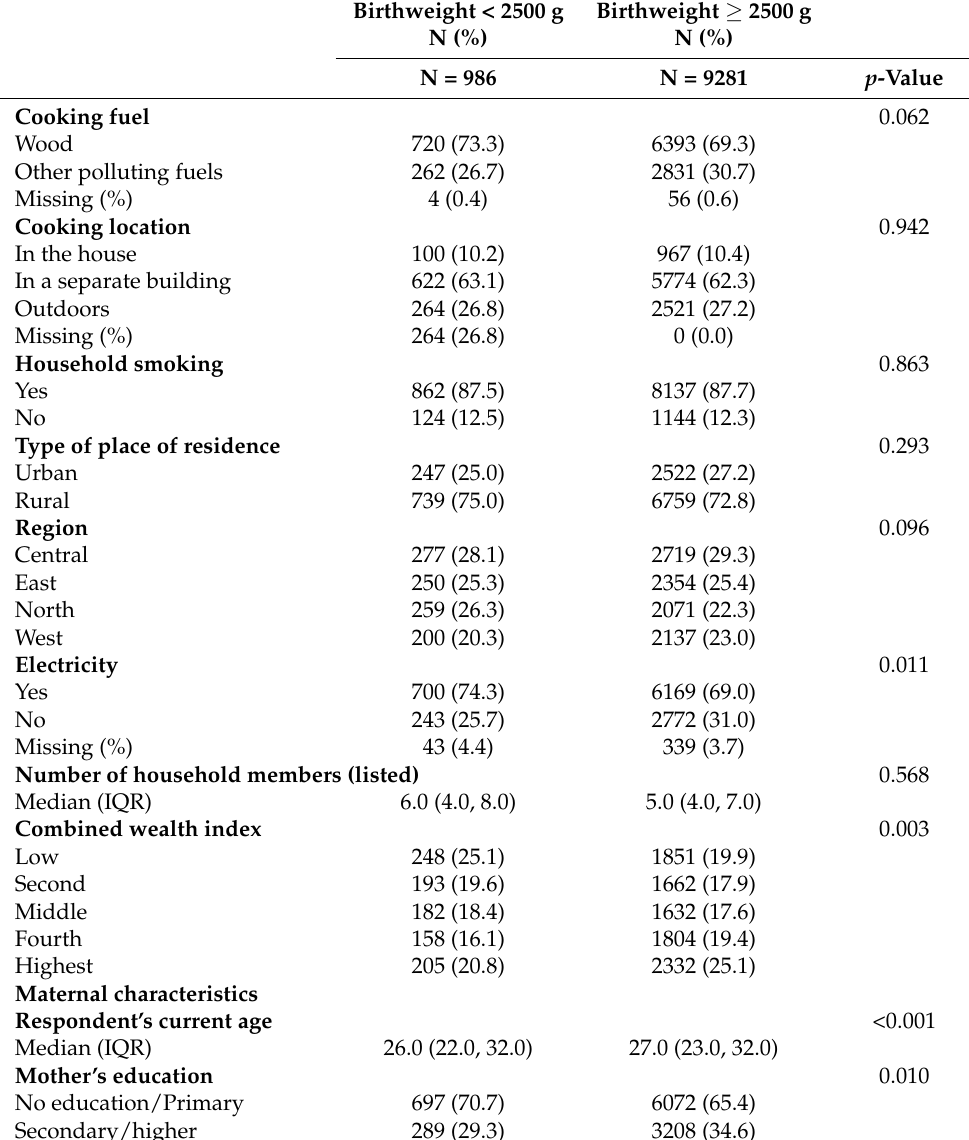
Table 1. Household characteristics by low birthweight classification of study